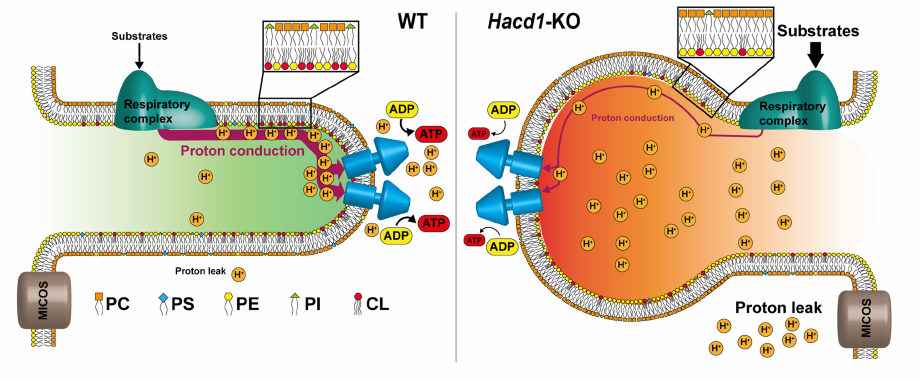
Figure 12. A proposed model of the molecular mechanism underlying the mitochondrial uncoupling in HACD1-deficient muscles. In wild type conditions, anionic lipids included in the cristae lumen leaflet of the IMM contribute to the translocation of protons to the tip of the cristae, where ATP synthase oligomers concentrate. In Hacd1 -KO mice, the decreased content of anionic lipids changes cristae shape, reduces efficiency of proton translocation, hence impairing ATP